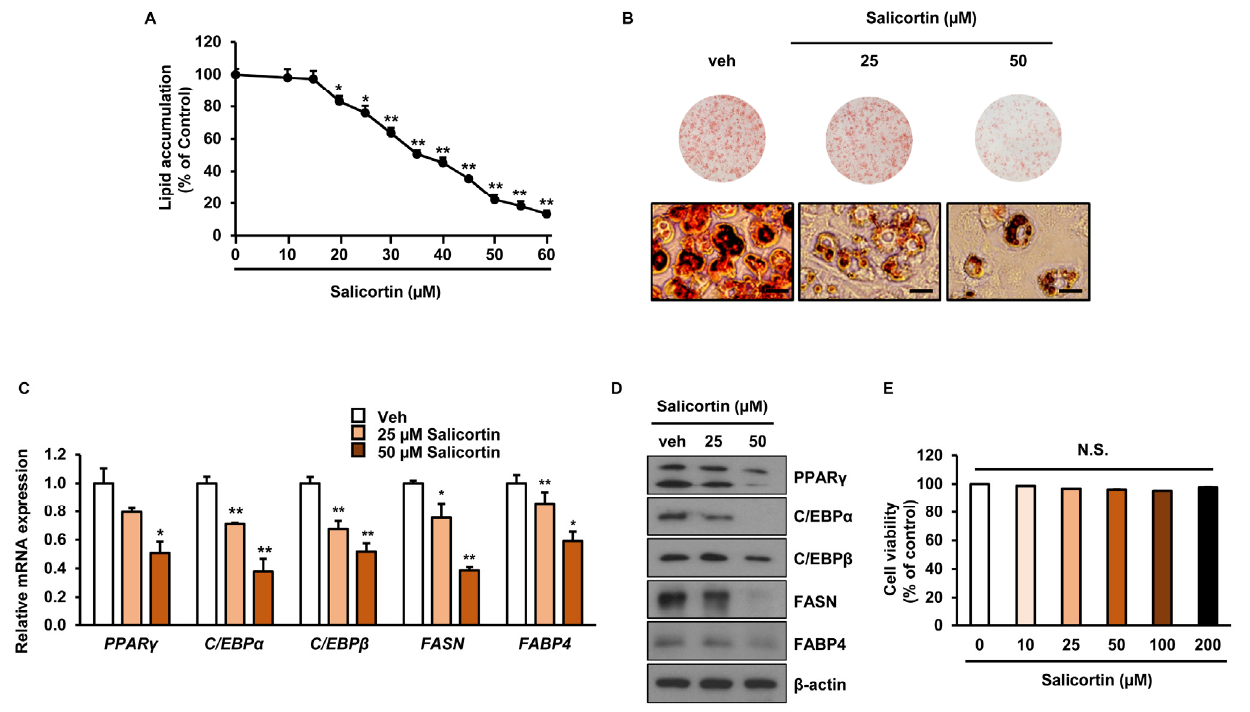
Figure 4. Inhibitory effect of salicortin on adipogenesis: ( A ) quantification of intracellular lipid accumulation in salicortin-treated 3T3-L1 cells compared to that in control cells; ( B ) Oil red O staining images ( top ) and microscopy ( bottom ) images in 3T3-L1 cells after 7 days of differentiation in either the absence or presence of salicortin at different concentrations. Scale bar = 100 µm; ( C ) gene expression quantification of PPAR γ , FASN, FABP4, C/EBP β , and C/EBP α , performed by real time qPCR; ( D ) immunoblot images of PPAR γ , FASN, FABP4, C/EBP β , and C/EBP α ; and ( E ) evaluation of salicortin cytotoxicity. ( B , C , E ), n = 3 per group. N.S., not significant; Veh, vehicle (negative control). The values represent the mean ± SEM. * p < 0.05, ** p < 0.01.